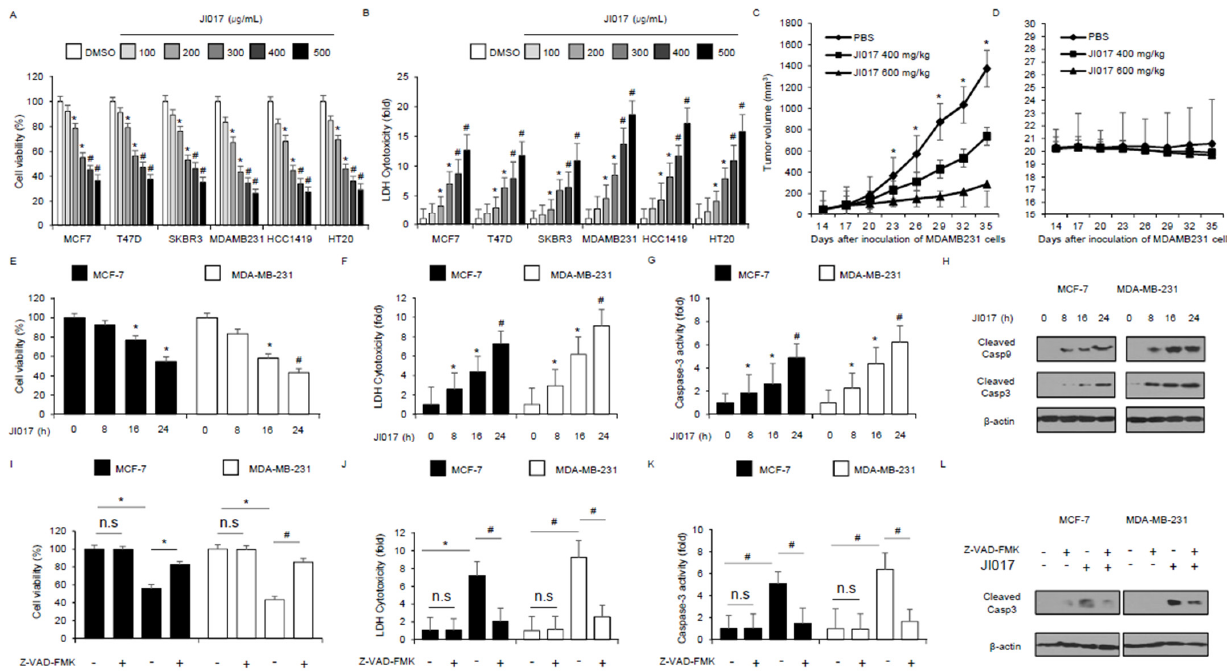
Figure 1. Cytotoxic effects of JI017 in breast cancer cell lines . ( A , B ) Cell viability and LDH cytotoxicity of a dose-dependent JI017, in breast cancer cell lines, including MCF-7, T47D, SK-BR-3, MDA-MB-231, HCC-1419, and HT20, measured using the WST-1 assay and LDH assay on 96-well plates; *, p < 0.05, #, p < 0.01. ( C , D ) MDA-MB-231 cells (1 × 10 7 ) were implanted (sc) into the thigh on the right hind leg of nude mice ( n = 10/group). JI017 (400 or 600 mg/kg) or PBS was administered (ip) once a day for two days. The longest (L) and shortest (W) axes of the tumors were measured, and the tumor volume (mm 3 ) was calculated as LW2/2. Body weights of the MDA-MB-231 tumor-xenograft mice were determined twice a week during the experiment. ( E – H ) JI017 is treated in a time-dependent manner (0, 8, 16, and 24 h; 300 µg/mL) and the WST-1 assay, LDH assay, and caspase-3 activity assays were performed. Western blotting analyses of cleaved caspase-3 and -9 for the indicated times in JI017-treated MCF-7 and MDA-MB-231 cells; *, p < 0.05, #, p < 0.01. β-actin was used as a protein loading control. ( I – L ) The effect of Z-VAD-FMK (50 µM) and JI017 treatment. MCF-7 and MDA-MB-231 cells were pre-treated with Z-VAD-FMK for 4 h and were subsequently treated with JI017 (300 µg/mL, 24 h). Cell viability was determined using the WST-1 assay; cell cytotoxicity was monitored using the LDH assay, and caspase-3 activity was assessed using the caspase-3 activity assay; *, p < 0.05, #, p < 0.01. To identify caspase-3 cleavage, Western blot assay performed. β-actin was used as a protein loading control.